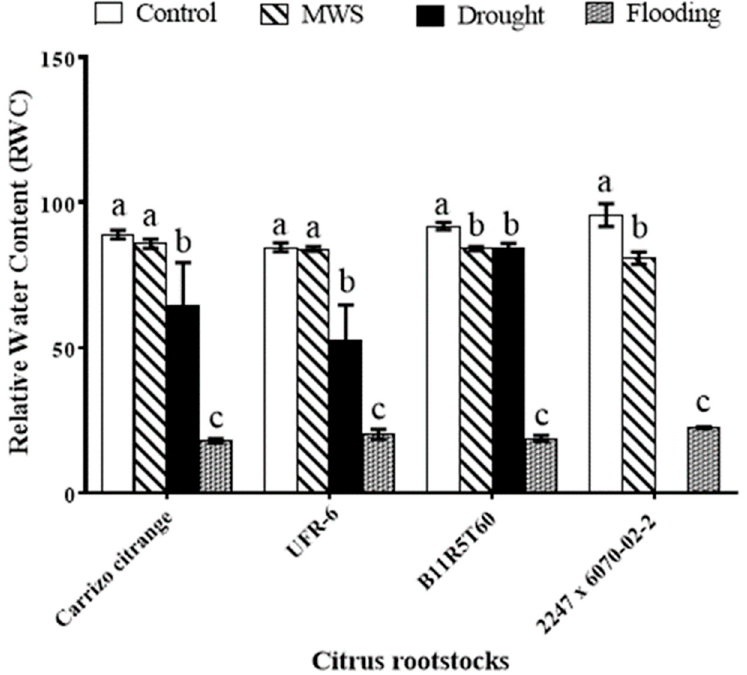
Figure 6. Relative water content (RWC) at day 30 of the assay in the four citrus rootstocks studied (Carrizo citrange, UFR-6, B11R5T60, and 2247 x 6070-02-2) and under four water treatments (Control, MWS, Drought, and Flooding). Values in columns with different letters denote statistical differences among treatments for each rootstock by Fisher’s LSD test ( p < 0.05). Note: data were not available for the Drought treatment of 2247 x 6070-02-2. MWS: Medium Water Stress.